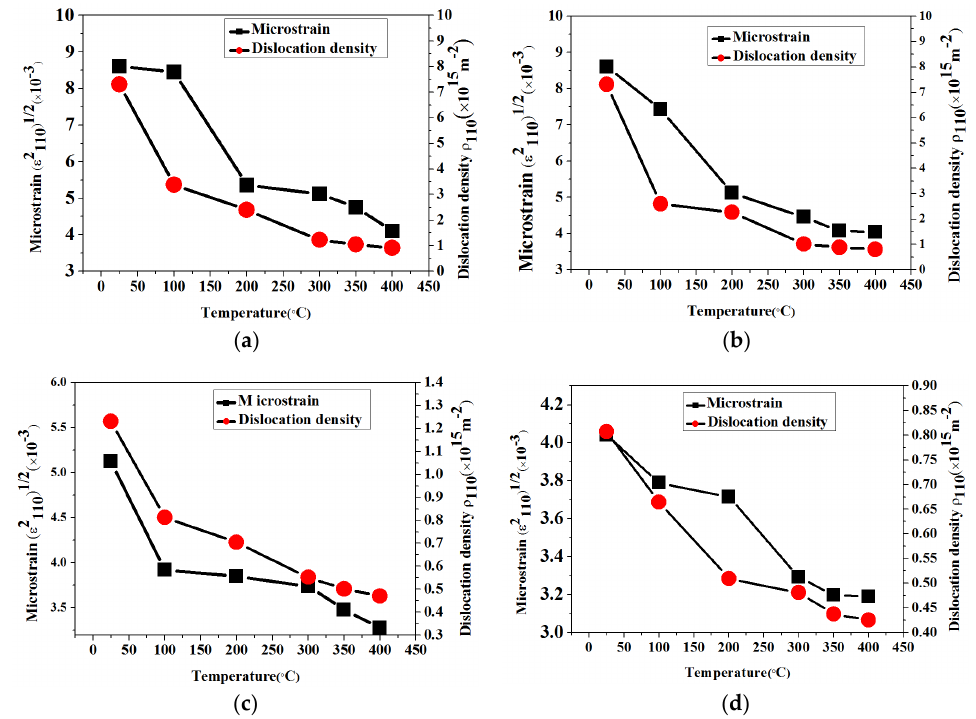
Figure 4. Microstrain and dislocation density variations of Mo thin films prepared in different heating modes at different temperature: ( a ) substrate heating; ( b ) annealing; ( c ) both substrate heating and 300 °C annealing; and ( d ) both substrate heating and 400 °C